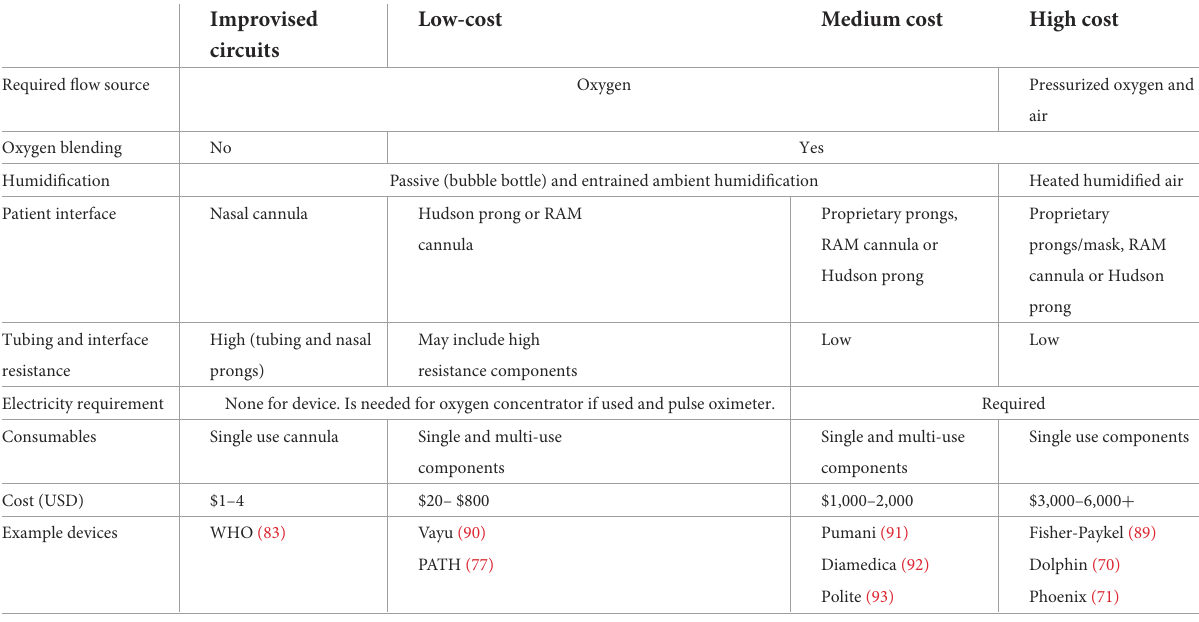
TABLE 2 Comparison of features and cost of CPAP device categories in use in